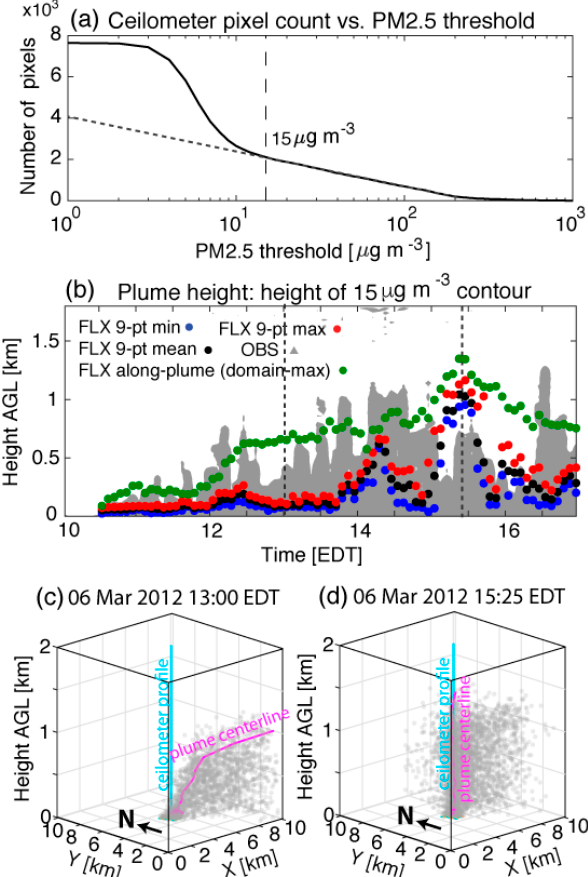
Figure 5. ( a ) Ceilometer pixel count as a function of PM 2.5 threshold used to mask background (i.e., ambient) PM 2.5 concentration (solid line), with 15 µ g m − 3 threshold (long dash line) and linear extrapolation below 15 µ g m − 3 (short dash line) indicated. ( b ) Time-height cross-sections of PM 2.5 concentration during the 2012 case (2012CL). Ceilometer observed PM 2.5 concentrations greater than or equal to 15 µ g m − 3 are shaded, and time series of the minimum, mean, and maximum height of